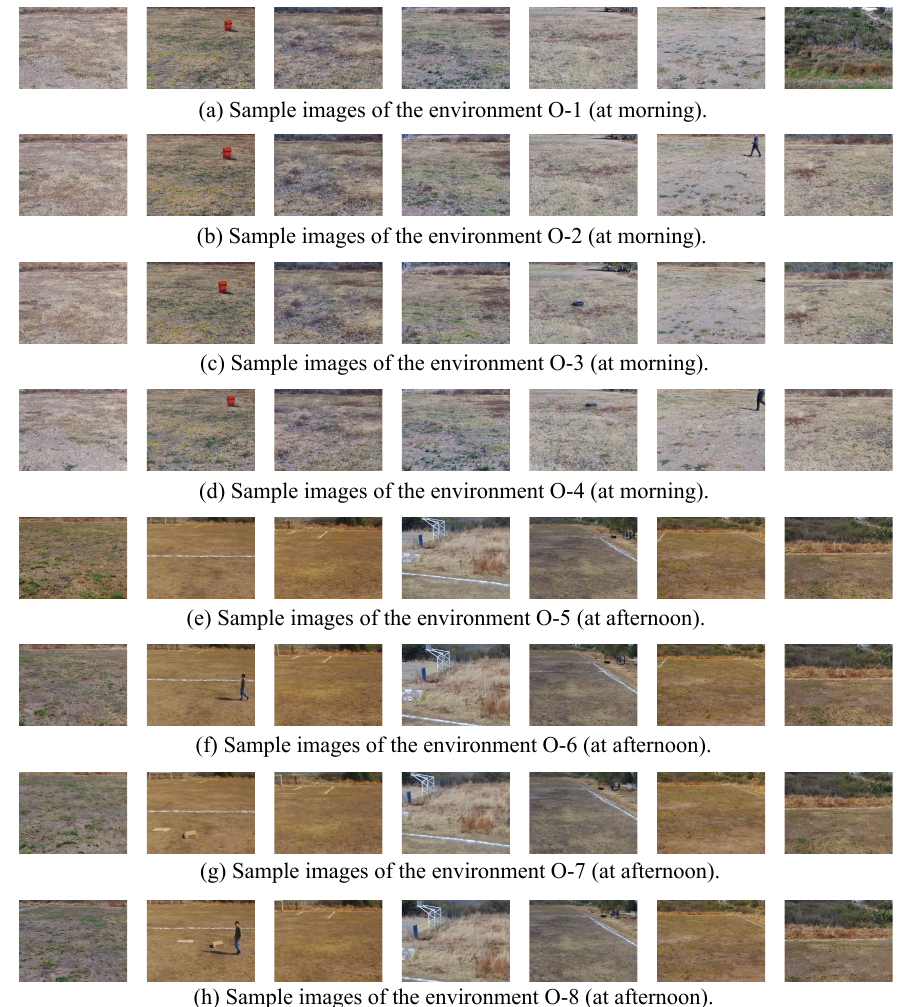
Figure 7. Sample images captured by the UAV in the environments: ( a ) original in the morning (O-1), ( b ) the person in the morning (O-2), ( c ) the tire in the morning (O-3), ( d ) the person and the tire in the morning (O-4), ( e ) empty environment in the afternoon (O-5), ( f ) the person in the afternoon (O-6), ( g